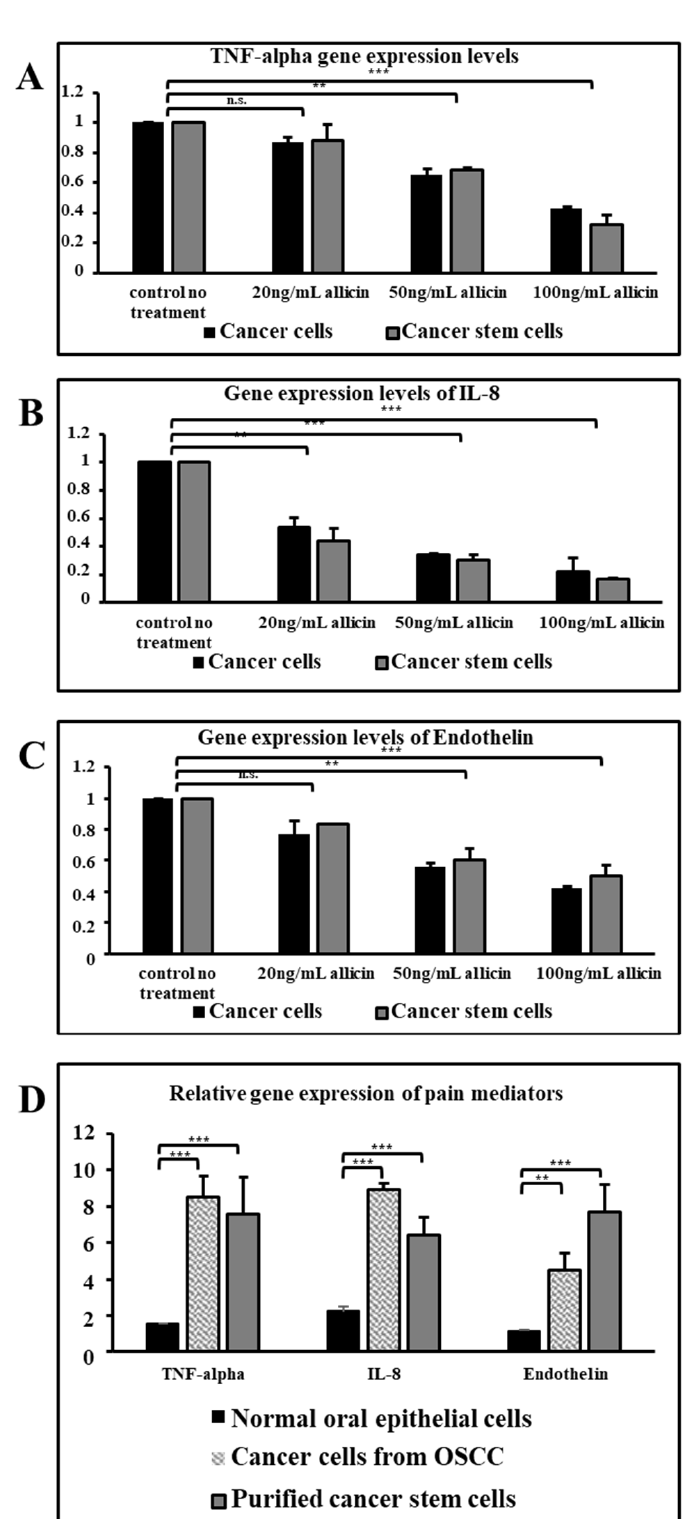
Figure 3. Real time PCR was performed to assess the gene expressions of pain mediators TNF- α , IL-8, and endothelin. ( A ) TNF- α gene expression levels. ( B ) IL-8 gene expression levels. ( C ) Endothelin gene expression levels. ( D ) Relative gene expressions of pain mediators. n.s. not significant, ** p < 0.05, *** p < 0.01 .